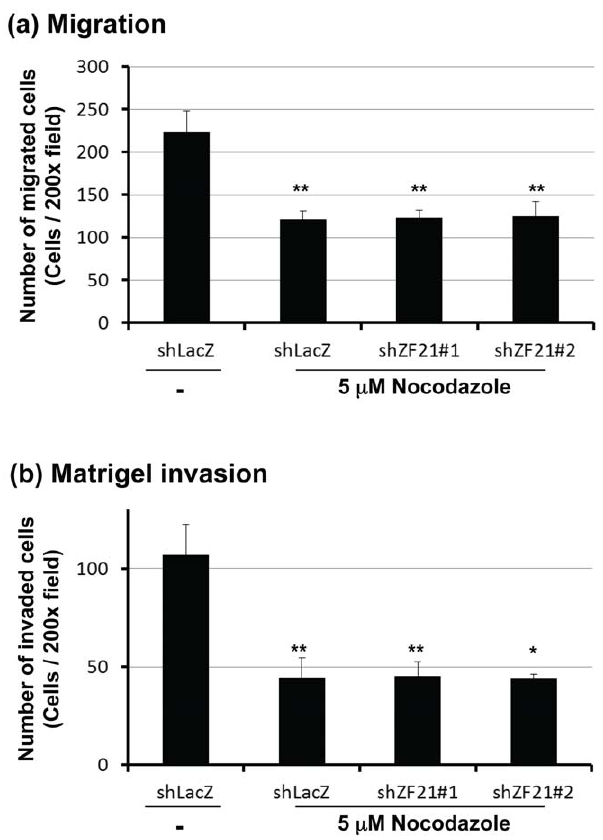
Figure 2. Microtubule disruption diminishes the effect of ZF21- knockdown on the invasive activity of the cells. In the presence of 5 m M nocodazole, the same set of cells indicated in Fig. 1D was subjected to migration (a) and matrigel invasion assays (b). Error bars indicate the means 6 S.D. (n=3).*, p , 0.05 **, p , 0.01 (Student’s t test).